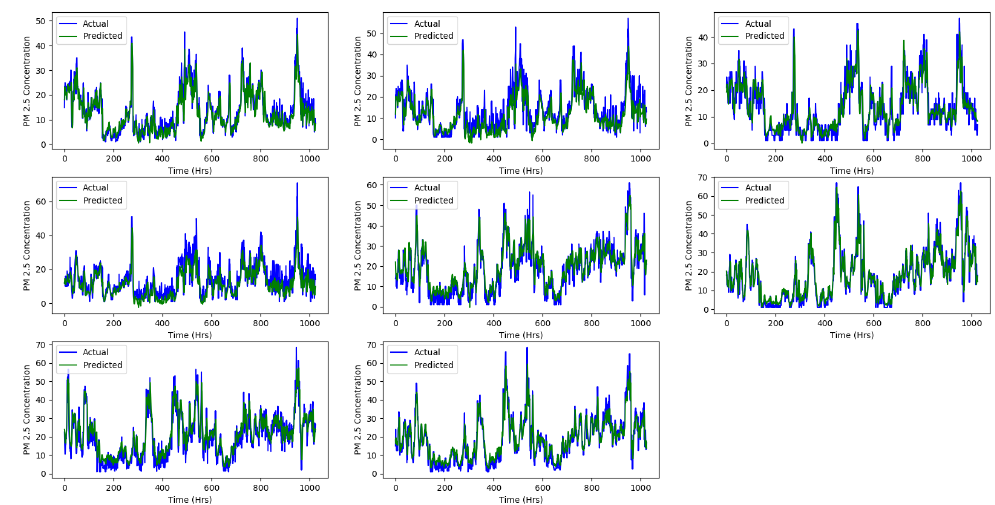
Figure 9. The predicted results of